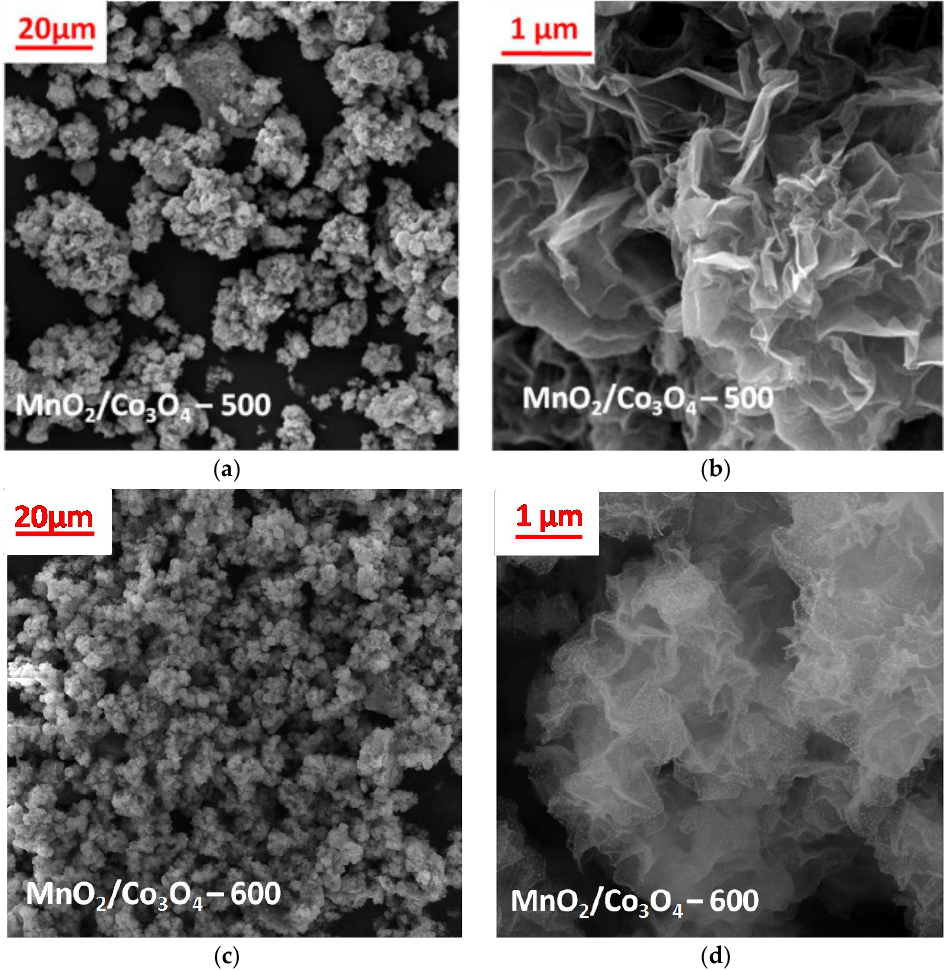
Figure 2. SEM images of ( a , b ) MnO 2 /Co 3 O 4 -500, ( c , d ) MnO 2 /Co 3 O 4 -600; at lower and higher magni-